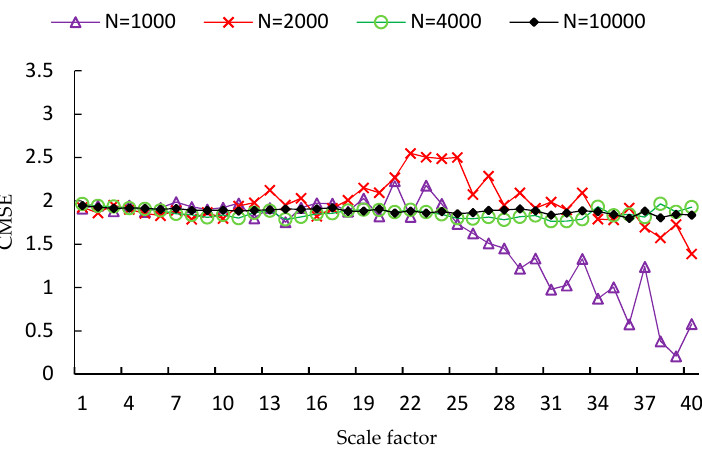
Figure 5. MSE values for 1/f noise signals with different lengths.